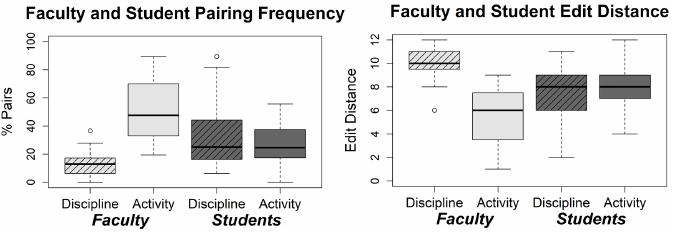
Fig. 3. Box-and-whisker plots for pairing frequency (left) and edit distances (right) of faculty and student sorts. Results of both participant groups are shown with respect to both the discipline-based framework (striped) and the activity-based framework (solid). Table 1. Descriptive statistics for faculty and student pairing frequency.